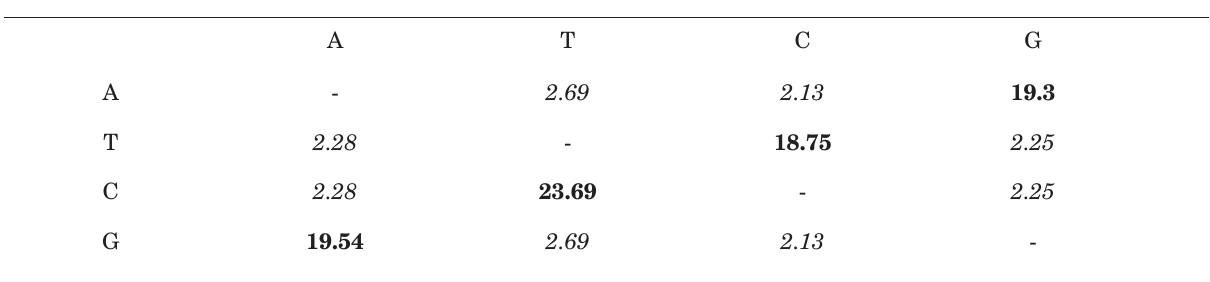
Table 2. Maximum composite likelihood estimate of the pattern of nucleotide substitution in Prune dwarf virus . Rates of different transitional substitutions are shown in bold and those of transversional substitutions in italics. Probability of substitution from one base (row) to another base (column)